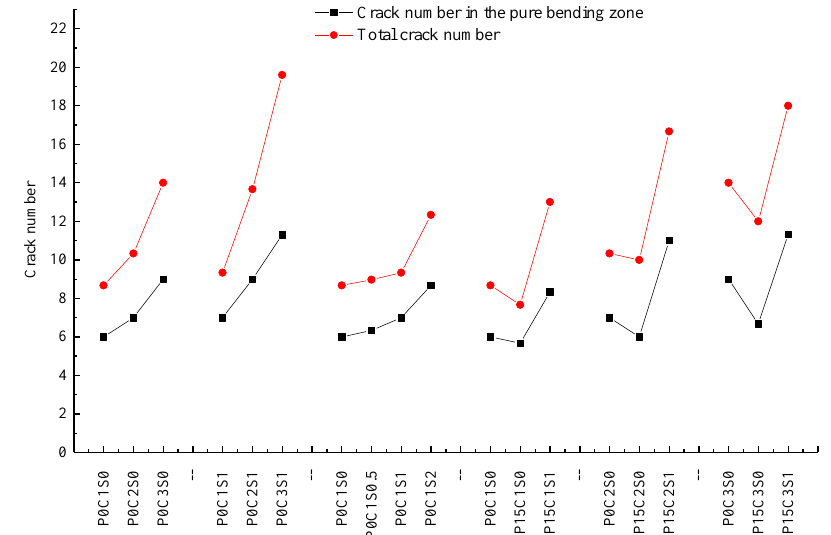
Figure 9. Crack patterns of the TRC specimens with different number of textile layers.